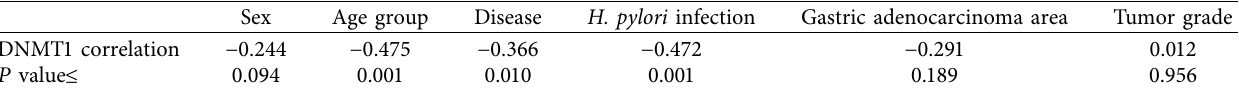
Table 6: Correlation of DNMT1 gene Δ Ct in gastric antral epithelial cells of patients with gastritis and gastric adenocarcinoma with the Spearman statistical test patients’ demographic